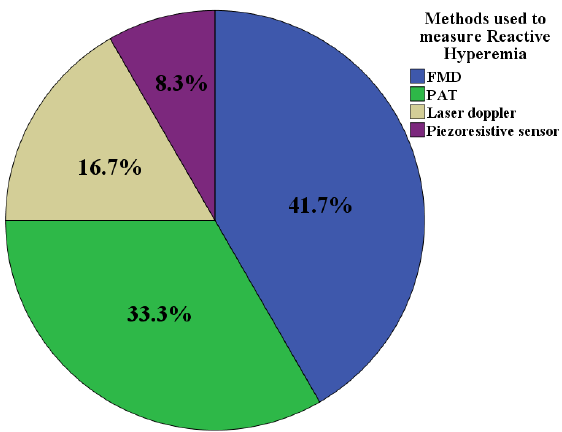
Figure 2. Methods used to measure reactive hyperemia (n = 11). Legend. FMD: flow-mediated dilation. PAT: peripheral arterial tonometry.